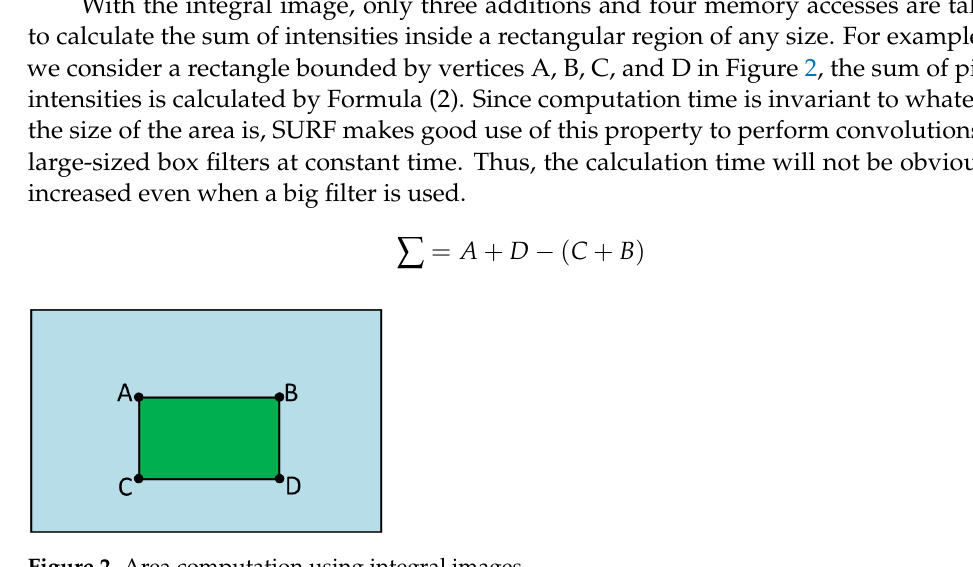
Figure 2. Area computation using integral images.